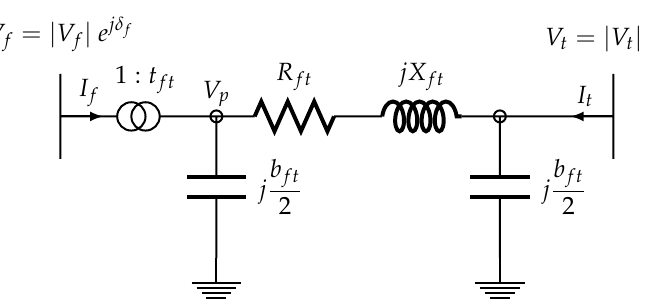
Figure 1. Generic branch model ( π -circuit) for modeling transmission lines ( t ft = 1 & φ ft = 0), in-phase transformers ( φ ft = 0) and phase-shifting transformers ( φ ft (cid:54) = 0). The transformer tap ratio is modeled only on the from-Bus side of the branch